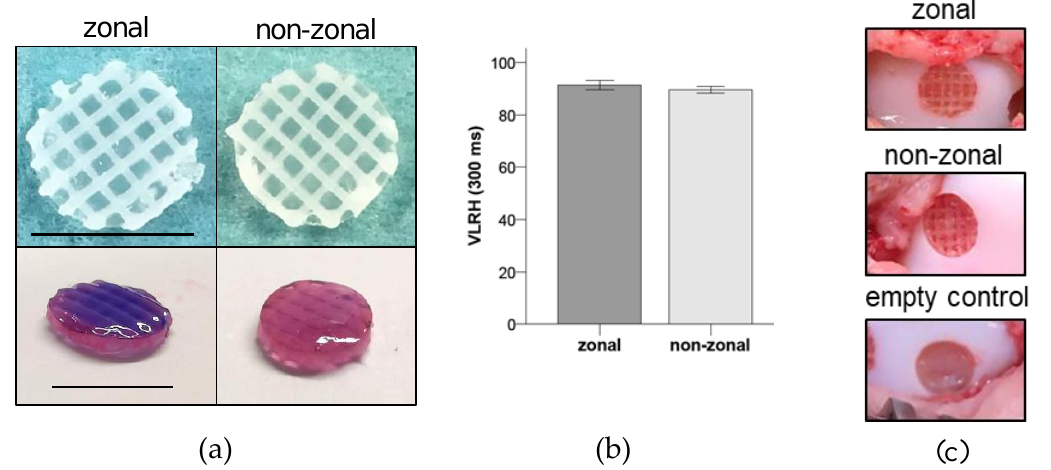
Figure 1. Design of enforced constructs and biomechanical properties. ( a ) The polycaprolactone (PCL) enforcement was soaked with 30 µL cell-containing starPEG hydrogel in a zonal (15 µL + 15 µL) or non-zonal design. Top: Top view on constructs ready for implantation. Bottom: Dark violet zone represents the mesenchymal stromal cell (MSC)-containing bottom zone of the zonal construct, light violet the chondrocyte-containing zone of both constructs. Scale bar = 6 mm. ( b ) Evaluation of the absolute hardness values very low rubber hardness (VLRH) of zonal and non-zonal implants. Mean ± SD. n = 5 per group. ( c ) Representative pictures of defects treated with zonal or non-zonal implants and the empty control directly before wound closure.